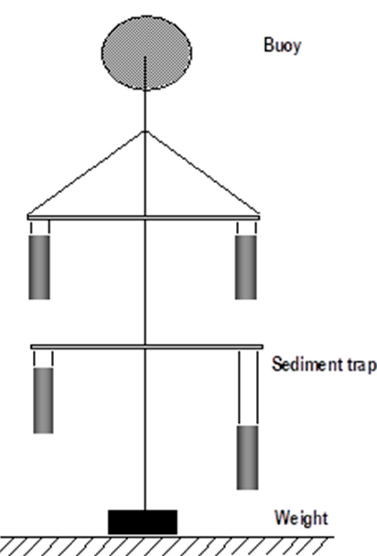
Figure 2. Sediment traps in the water column on the construction, which was built for the purpose of